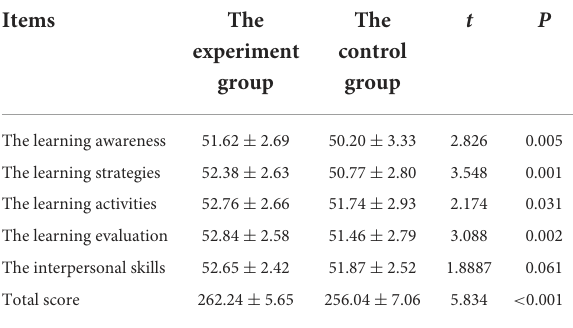
TABLE 5 The comparison of the self-directed learning ability between the two groups of intern nursing students after the internship.